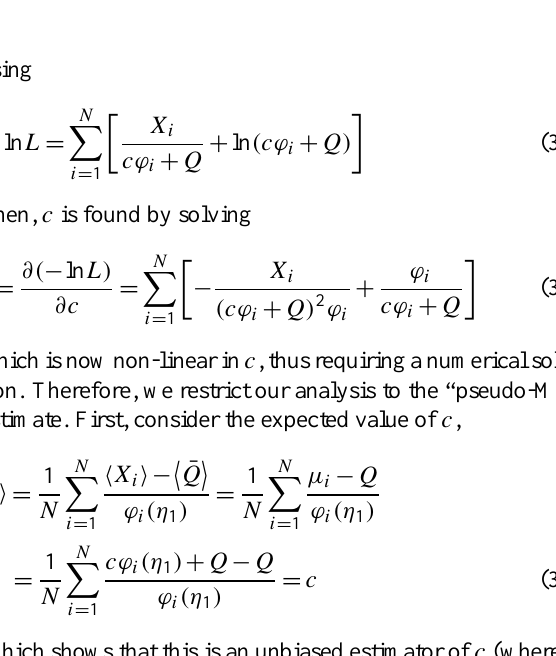
Fig. 7. The effect of the weighting function on the log-likelihood function as a function of η 1 in